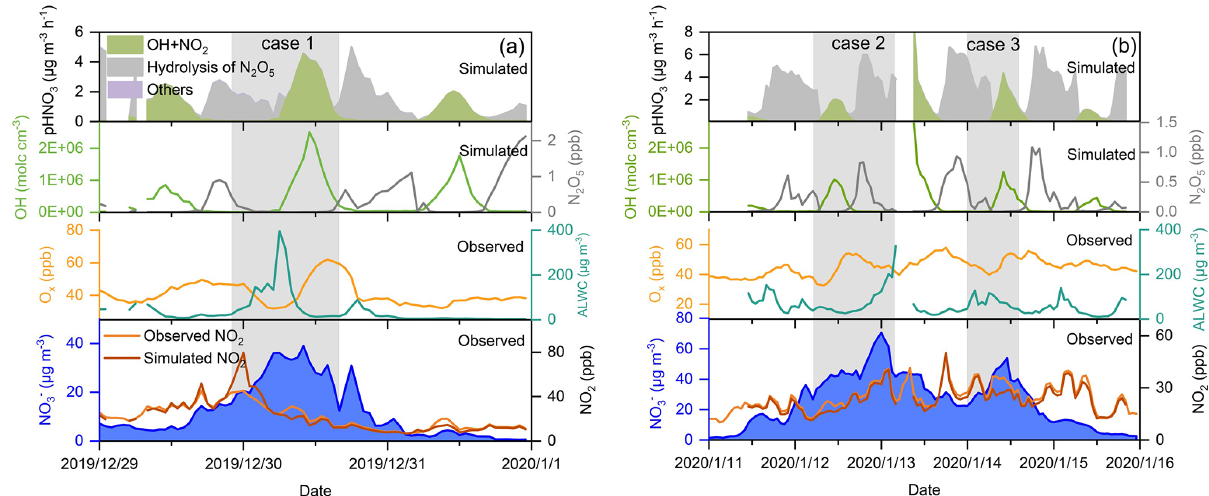
Figure 8. Time series of particulate nitrate, NO 2 , O x , ALWC, OH, and N 2 O 5 , as well as the formation rate of HNO 3 from different processes during the two selected cases during the pollution episodes at the Pudong site in 2019. The simulated data with RH > 95% were not included in the figure (see main